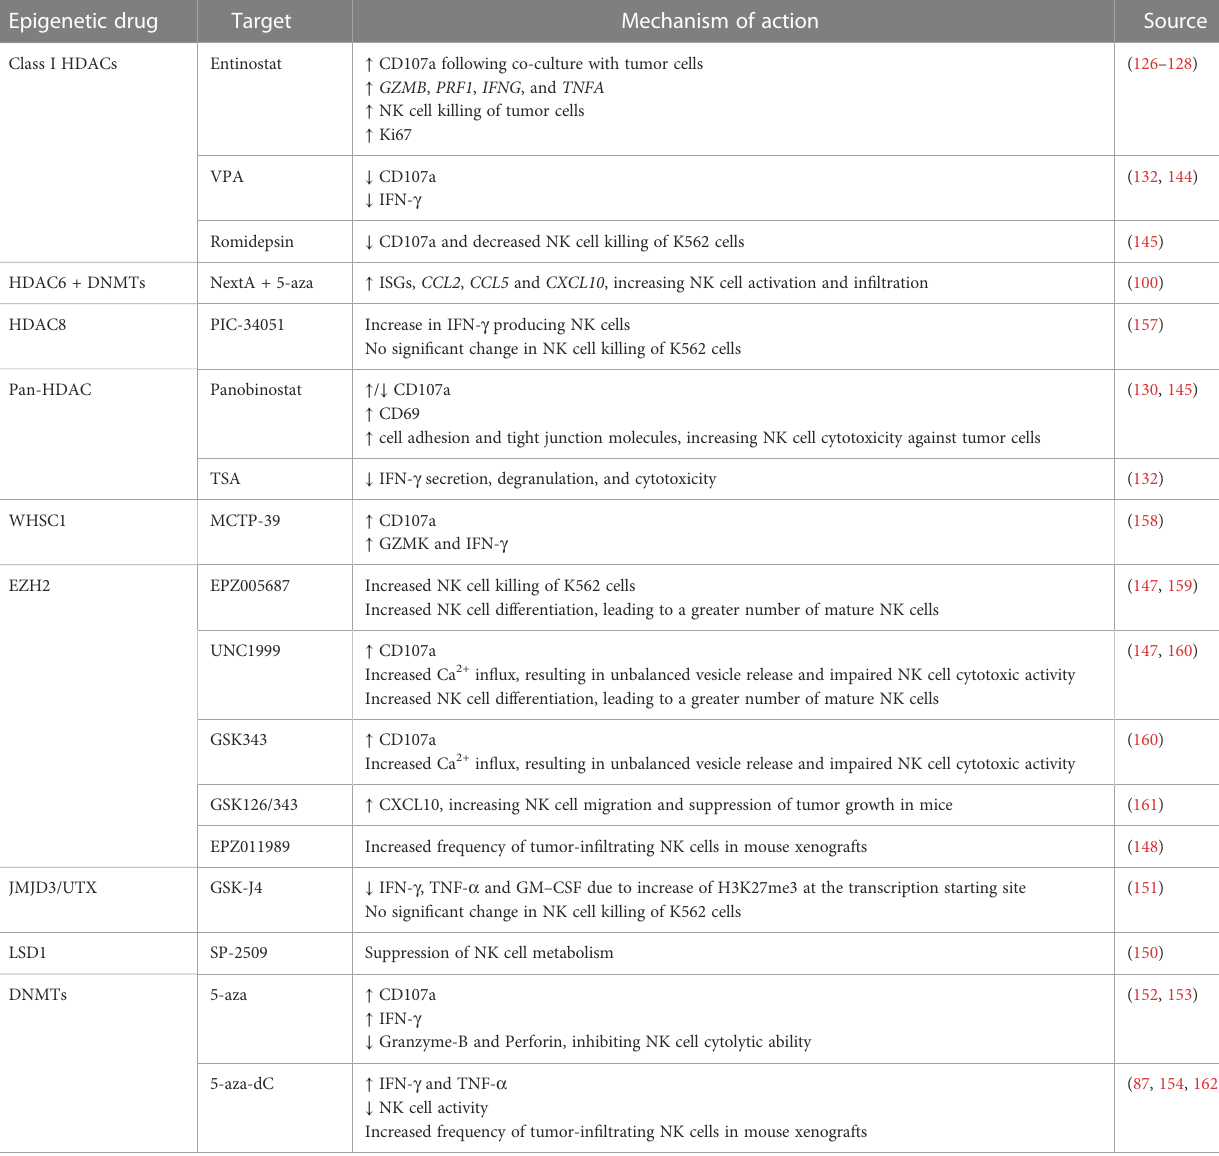
TABLE 4 Effect of epigenetic modulating agents on NK cell function, in fi ltration, and development. Epigenetic